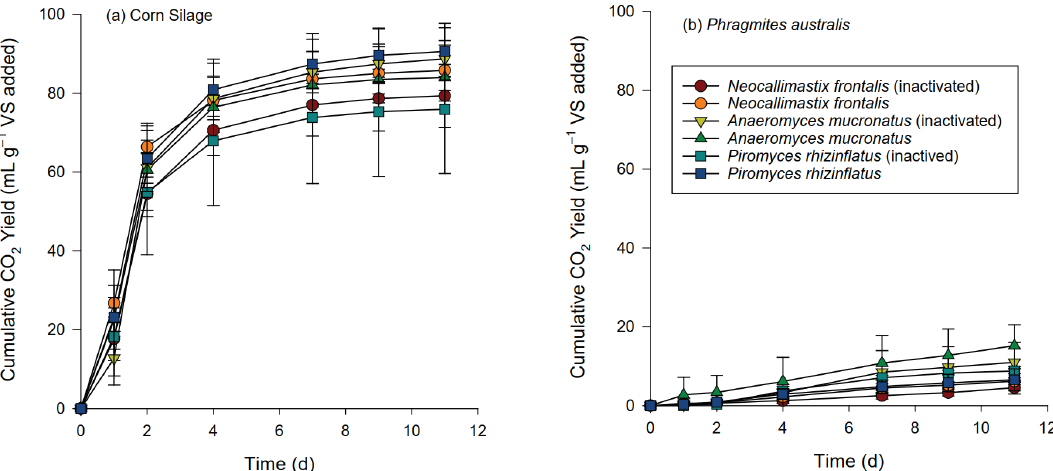
Figure 2. Cumulative carbon dioxide yield in the bioaugmentation of three different anaerobic fungal species: ( a ) corn silage ( Zea mays L.); ( b ) common reed ( Phragmites australis ). Error bars show standard deviation.